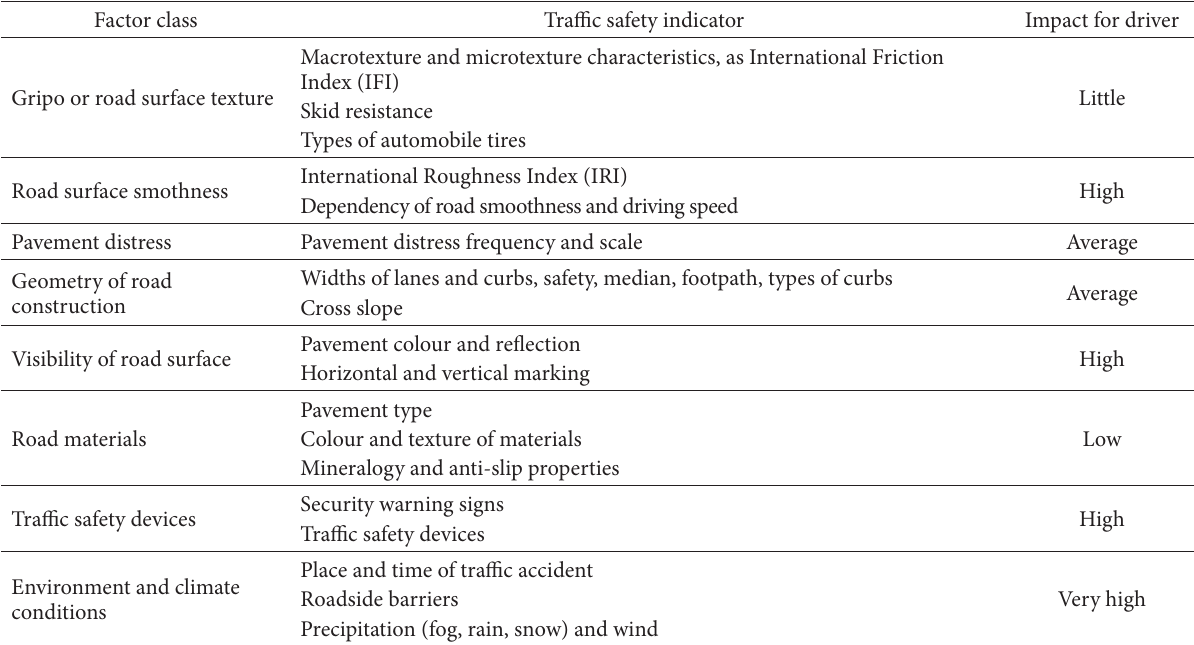
Table 1. Traffic safety indicators and the impact to drivers‘s behaviour Factor